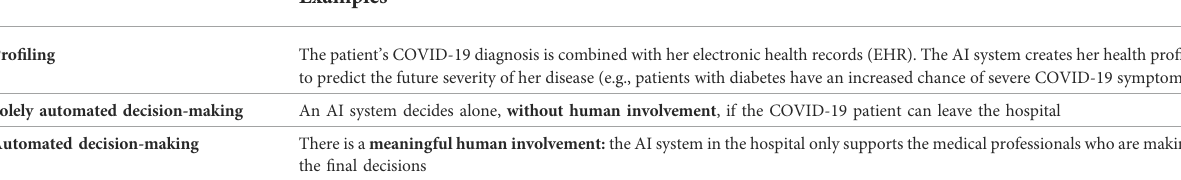
TABLE 1 Examples of pro fi ling and (solely) automated decision-making in healthcare services related to COVID-19.